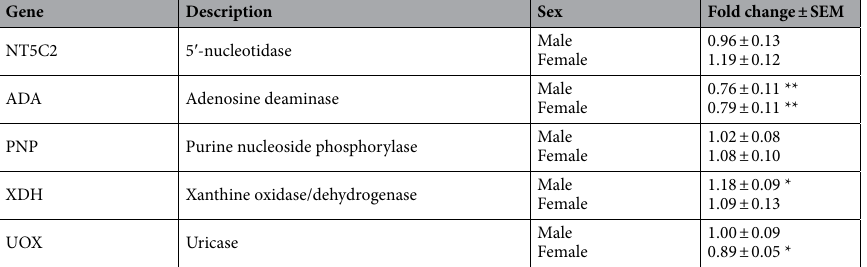
Table 4. Purine metabolism gene panel RT-qPCR results. mRNA levels in the livers of 19 week old prenatally Dex-exposed offspring relative to saline control. Fold changes in gene expression were calculated by relative quantification (ΔΔCt) of RT-qPCR threshold cycles (Ct) as per Livak and Schmittgen 28 using mean Ct values of housekeeping genes GAPDH and Rpl32. Data is expressed as mean fold change of Dex relative to the saline group ± SEM (n = 8). Unpaired t-test: Statistical significance between groups is shown by: * p < 0.05, ** p < 0.01.